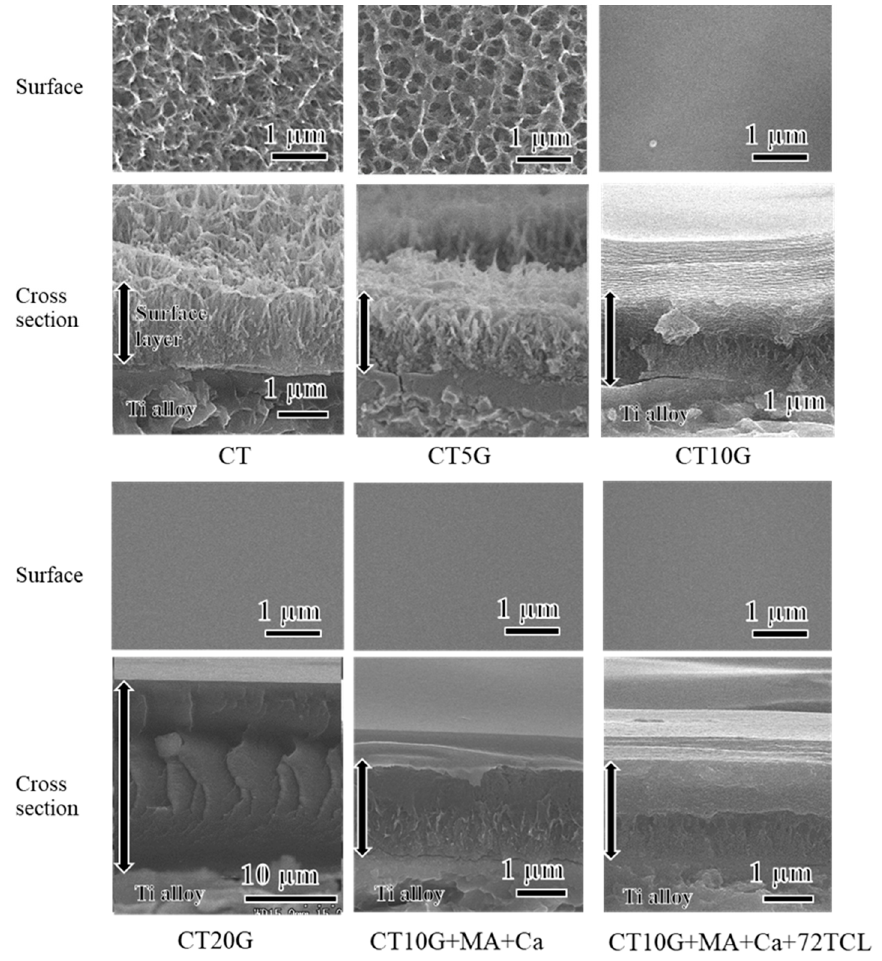
Figure 2. Surface and cross-sectional SEM images of Ca-heat treated Ti–6Al–4V alloy subjected to dip coating with various additives and subsequent thermal cross-link treatment.